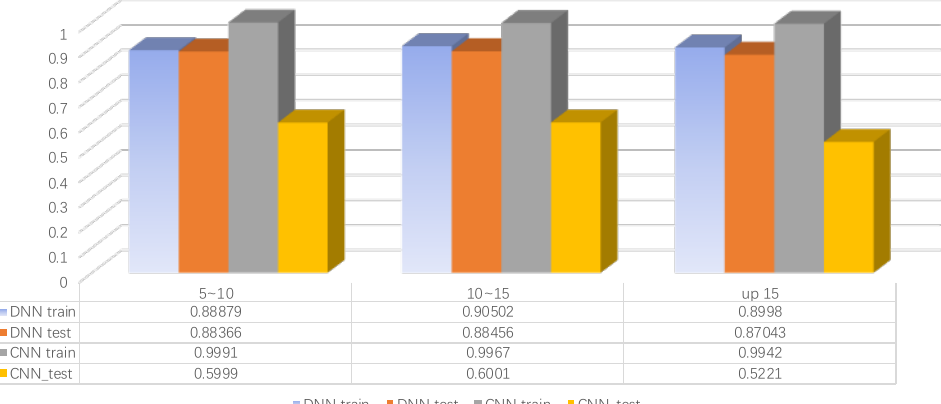
Figure 11. Comparison of classification accuracy between DNN and